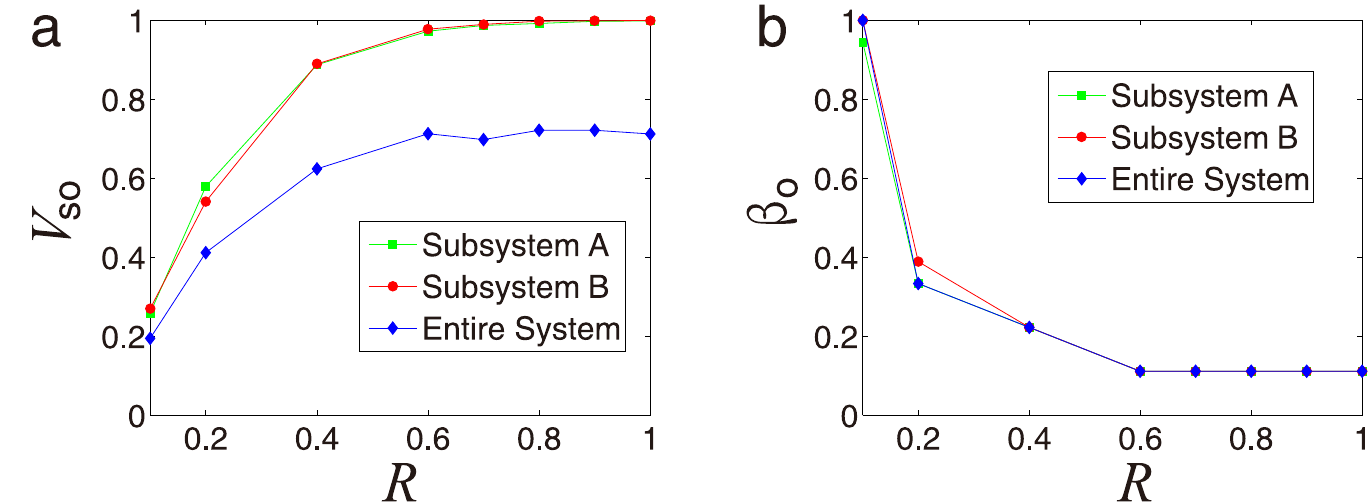
Fig 7. Radius effect for predator-prey relationship. (a) Optimal synchronization V so as a function of radius R for each subsystem and the entire system. (b) Optimal coupling strength β o as a function of radius R for each subsystem and the entire system. All the data points are in S6